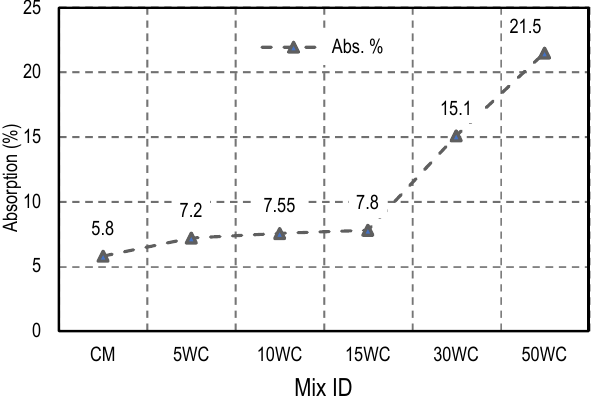
Figure 7. Water absorption values for different mixes.